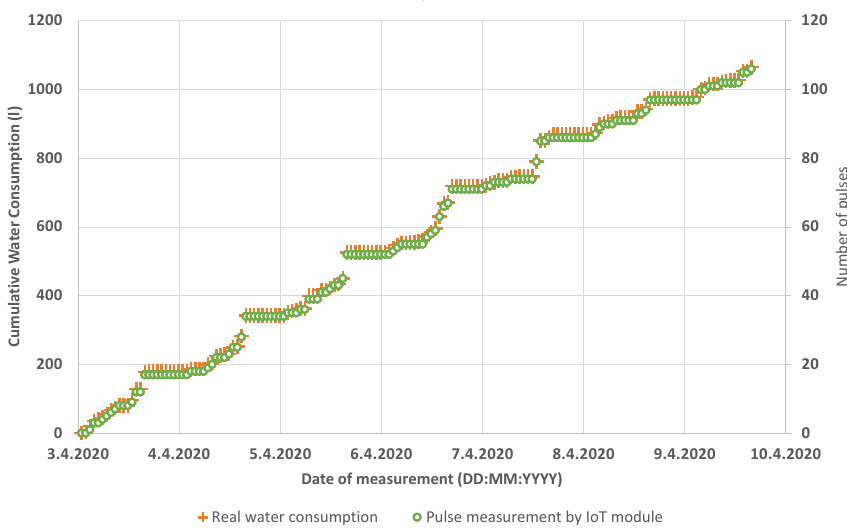
Figure 14. Comparison between remote and manual reading—hot water.